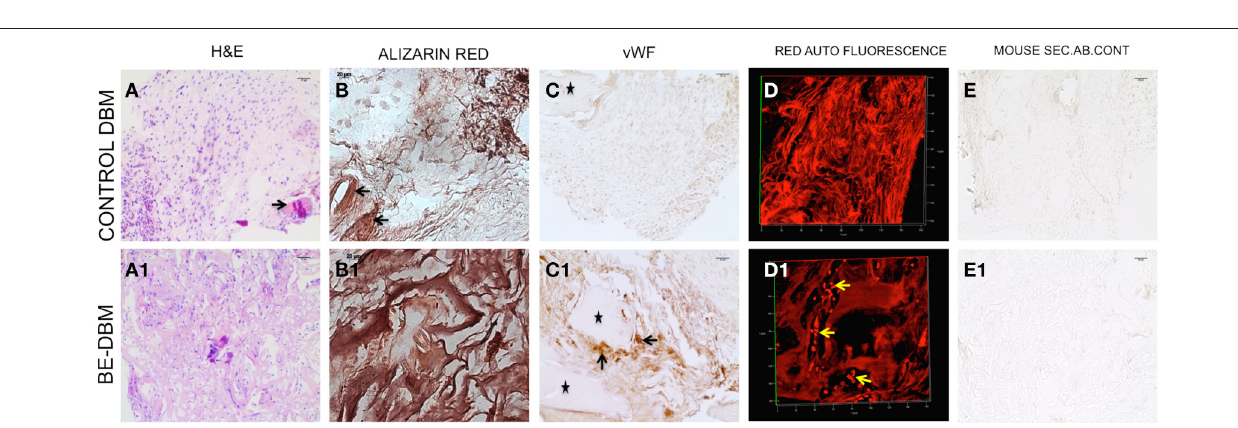
FIGURE 7 | Histology of DBM and BE-DBM in vivo explants. (A,A1) Represent H&E stained sections of DBM and BE-DBM explants, respectively. The arrow in (A) points to a cortical bone chip. (B,B1) Represent alizarin red stained sections from DBM and BE-DBM explants. (C,C1) Represent DBM and BE-DBM sections immunohistochemically stained for von Willebrand factor. The arrows in (C1) point to positively stained endothelial cells in the BE-DBM section. *Symbols in (C,C1) represent cortical bone chips. (D,D1) Represent 3D confocal images of red channel auto fluorescence from H&E stained DBM and BE-DBM sections. The yellow arrows in (D1) point to RBCs. (E,E1) Represent mouse secondary antibody controls for the DBM and BE-DBM sections. Scale bar in all other images represents 20 µ